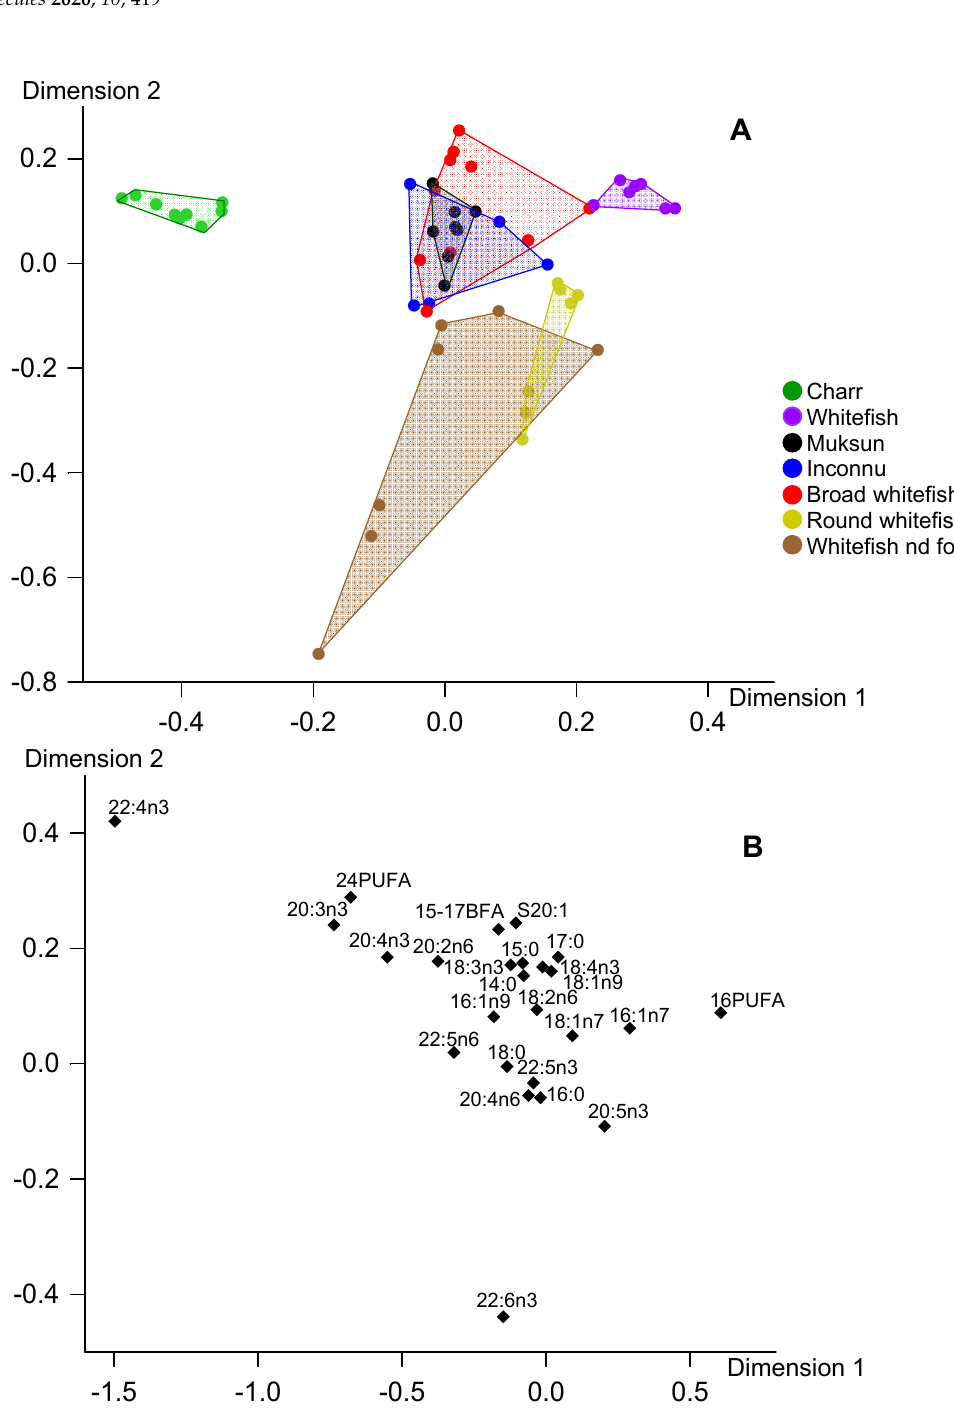
(Table 4). Round whitefish had significantly higher levels of 16:1n ‐ 7, 18:1n ‐ 7 and C16 PUFA compared to those of the other fish. Muksun and whitefish of the non ‐ identified form had intermediate levels of most FA in PL (Table 4).